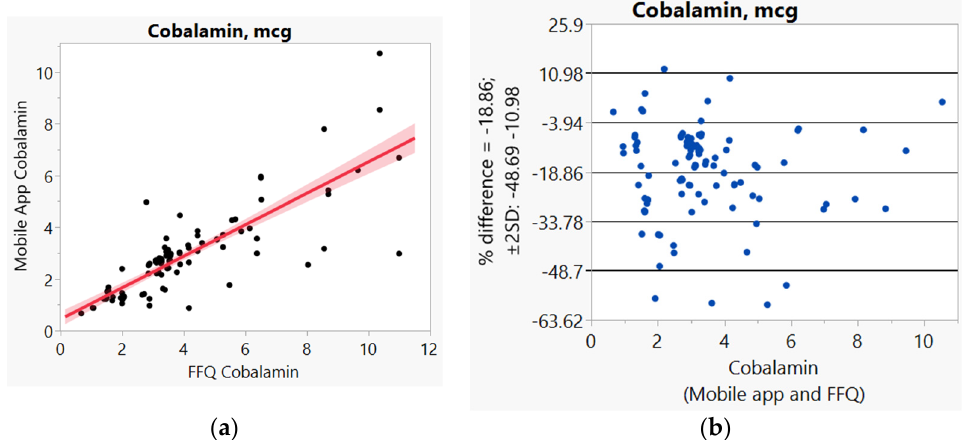
Figure 4. ( a ) Correlation, ( b ) Bland and Altman plots between mobile applications and Food Fre- quency Questionnaire (FFQ) for cobalamin.